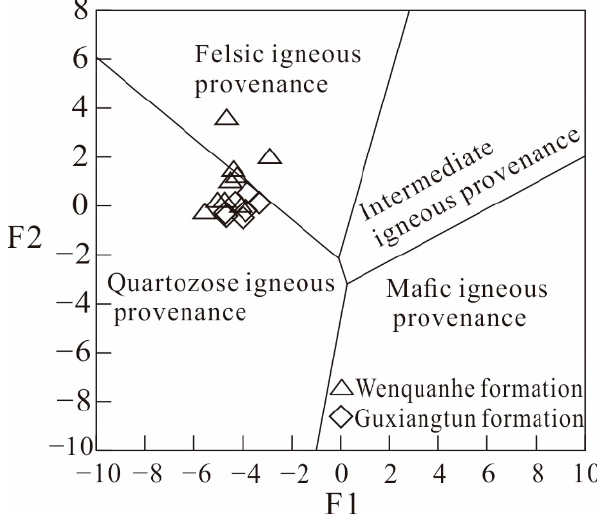
Figure 8. Classification plot of discriminant functions F1 and F2 for the Songhua River sediments. Provenance fields are from Roser and Korsch [36].